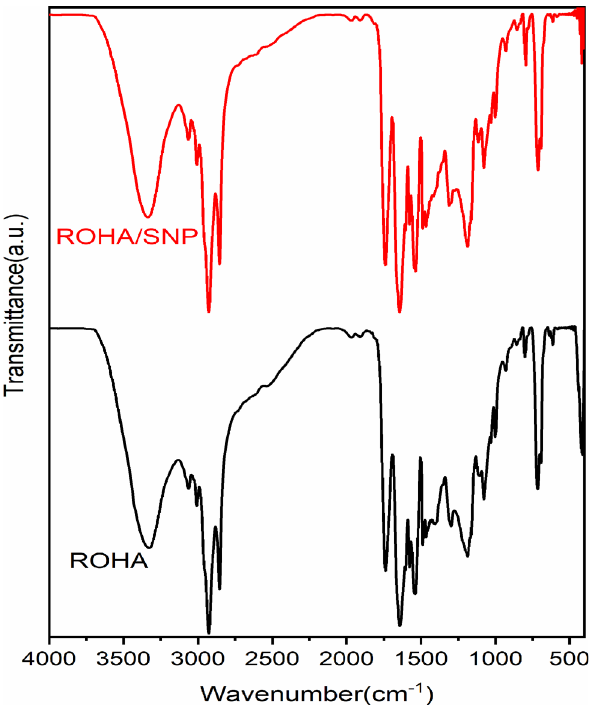
Figure 1: FTIR spectra of ROHA and ROHA/SNP nanocomposite.